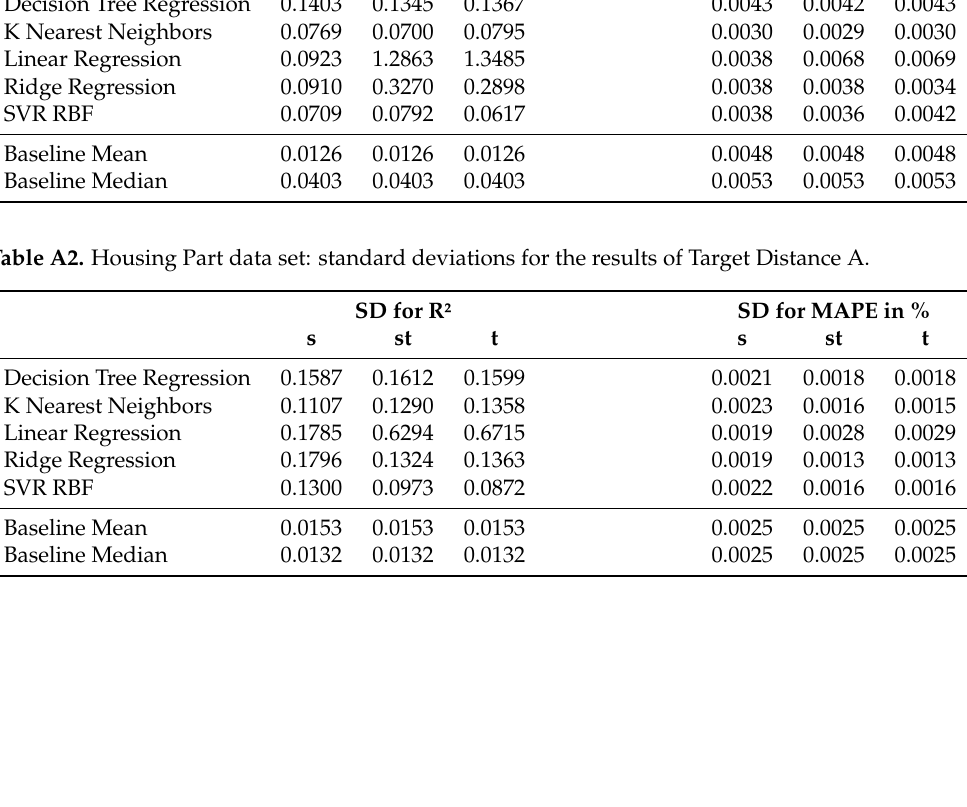
Table A1. Housing Part data set: standard deviations for the results of Target Weight. SD for R² SD for MAPE in %